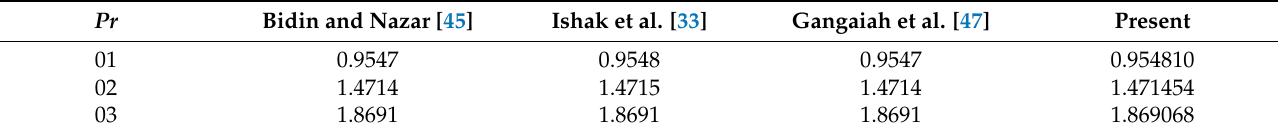
Table 1. Comparative behavior of − θ (cid:48) ( 0 ) for different values of Pr when M = Gr T = Gr C = Y = S = Ec = D 1 = E 1 = α = λ = 0, Nb = 0.5, Nt = 0.5.